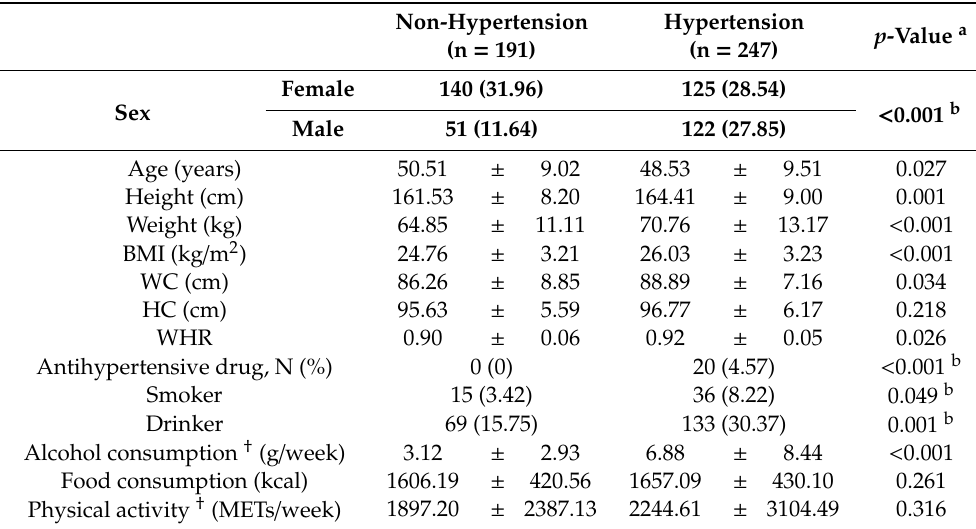
Table 1. General